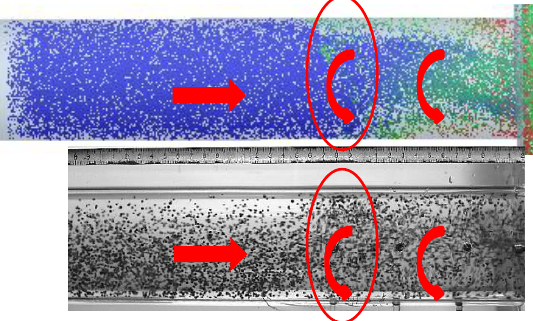
Figure 19. Comparison of particles flow at pump inlet section between numerical and experimental.